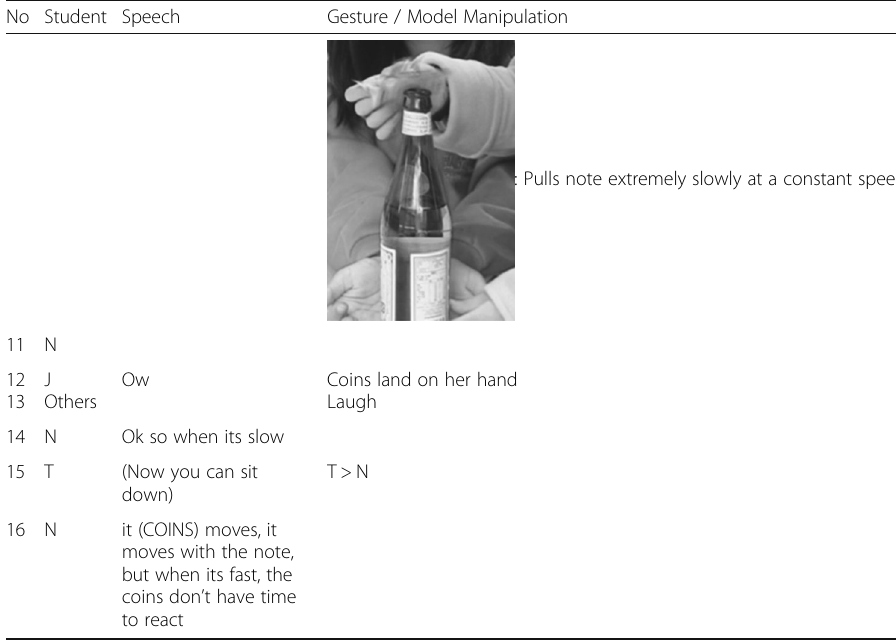
Table 2 Using Alternative Modes to Test an Idea in Group 1 (Continued) No Student